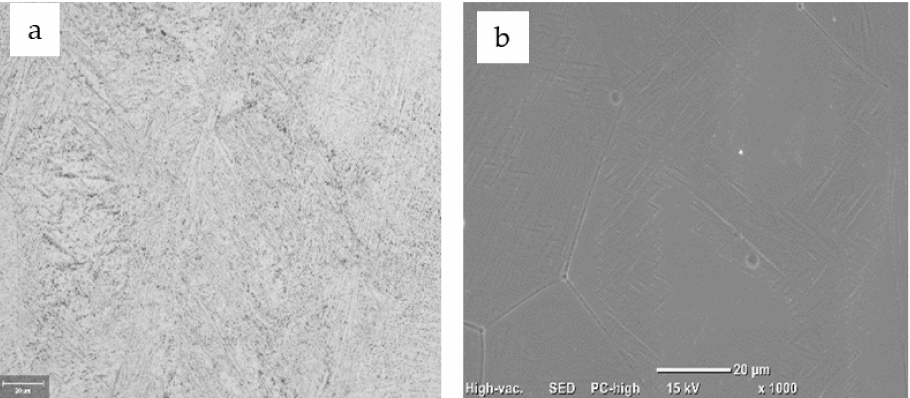
Figure 7. OM microstructure of the processed alloys: ( a ) Ti10Nb10Zr5Ta; and ( b )